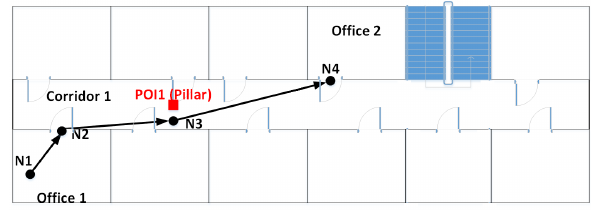
Figure 8. Example of a path in a floor Semantics from IndoorLocationGML supports